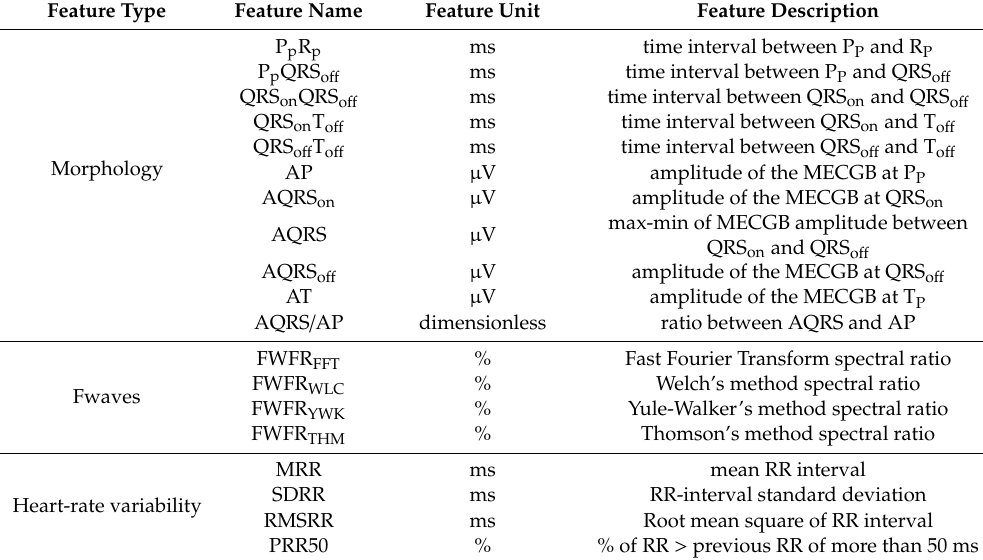
Table 1. Summary of the 19 ECG features (11 on morphology, 4 on F waves and 4 on heart-rate variability) characterizing each ECG